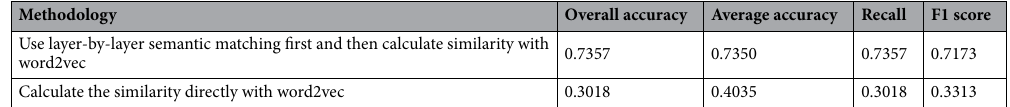
Table 8. Comparison of the results of the semantic similarity calculation methods.